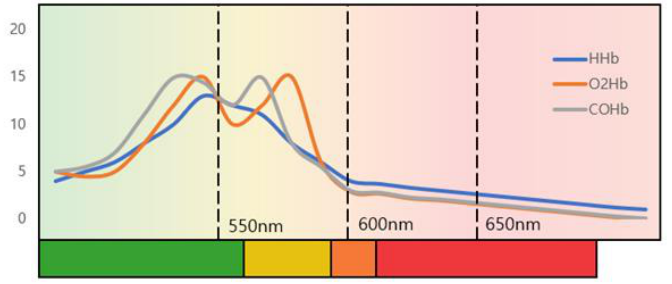
Figure 1. The absorbance of hemoglobin according to the wavelength of light.